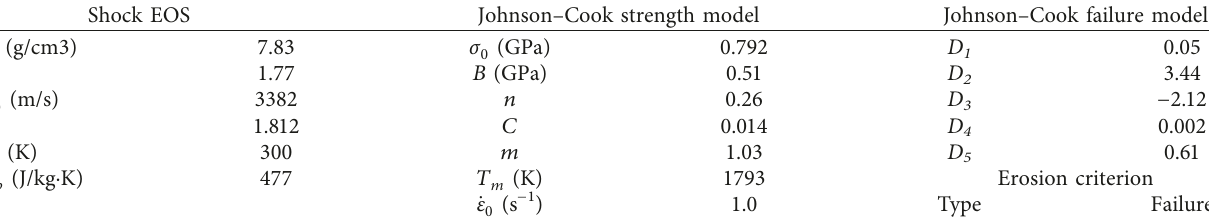
Table 2: Material parameters of 4340 stainless steel.